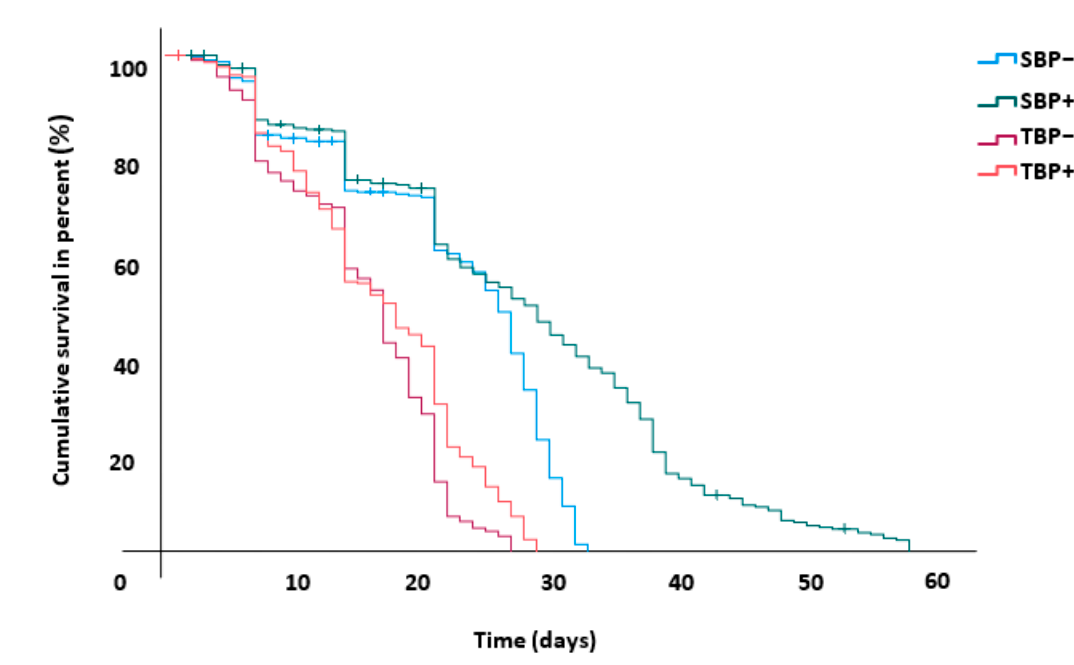
Figure 4. Cumulative survival in percent of worker bees. SBP+: A. mellifera sahariensis pollen-fed, SBP − : A. mellifera sahariensis pollen-deprived, TBP+: A. mellifera intermissa pollen-fed, TBP − : A. mellifera intermissa pollen-deprived. Table 1. Kaplan–Meier estimate of survival time of Apis mellifera sahariensis and Apis mellifera inter- missa according to diet (pollen-fed and pollen-deprived) , with confidence interval (95% CI), results expressed as (mean ± standard error), and letters indicate significant difference test (Gehan–Wil- coxon test).